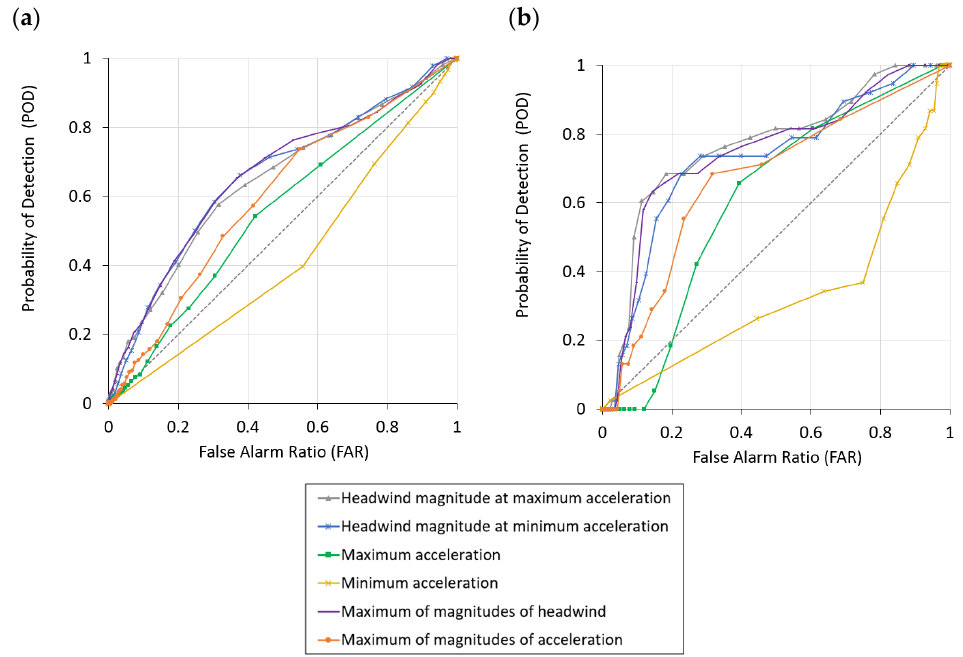
Figure 10. Example receiver operating characteristic curves for all metrics calculated for ( a ) 07LA maximum wind speed horizontal acceleration and ( b ) 07RA typical wind speed vertical acceleration.